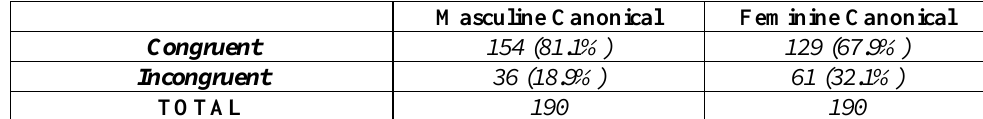
Table 4. Distribution of responses from forced-choice judgment task for canonical ending stimuli